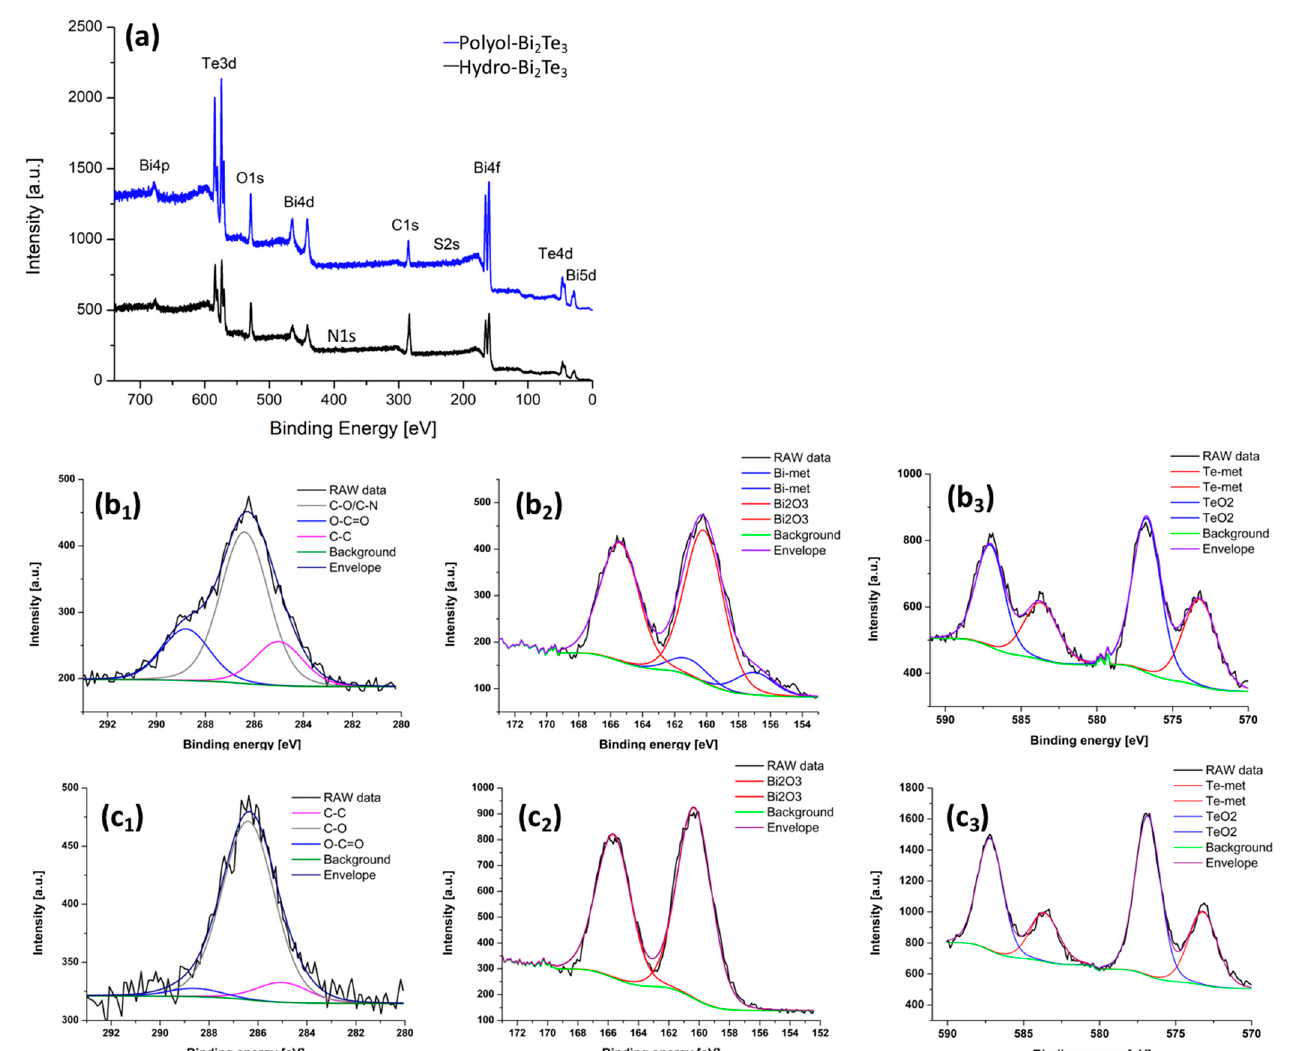
Figure 3. X-ray photoelectron spectroscopy (XPS) survey scan ( a ), and C 1s ( b 1 , c 1 ), Bi 4f ( b 2 , c 2 ) and Te 3d ( b 3 , c 3 ) spectra for Bi 2 Te 3 samples synthesized through MW-assisted hydrothermal ( b ), and polyol ( c ) routes. Table 2. XPS peak fitting results for Bi 4f, and Te 3d, O 1s, C 1s, S 2s and N 1s regions, and the